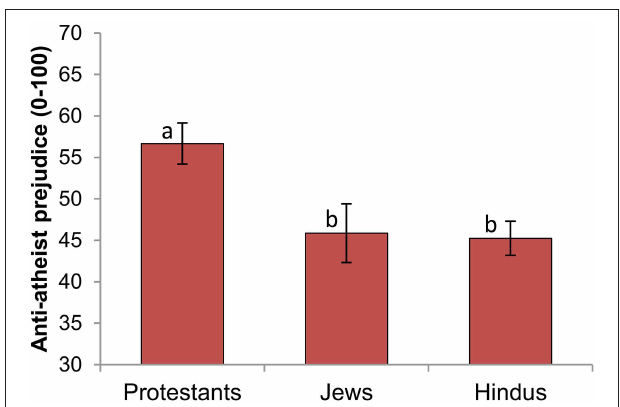
FIGURE 1 | Negative feelings toward atheists, by participants’ religious group membership. Error bars indicate ± 1 SE. Different subscripts indicate that these bars differ from each other at the p < 0 . 05 level.